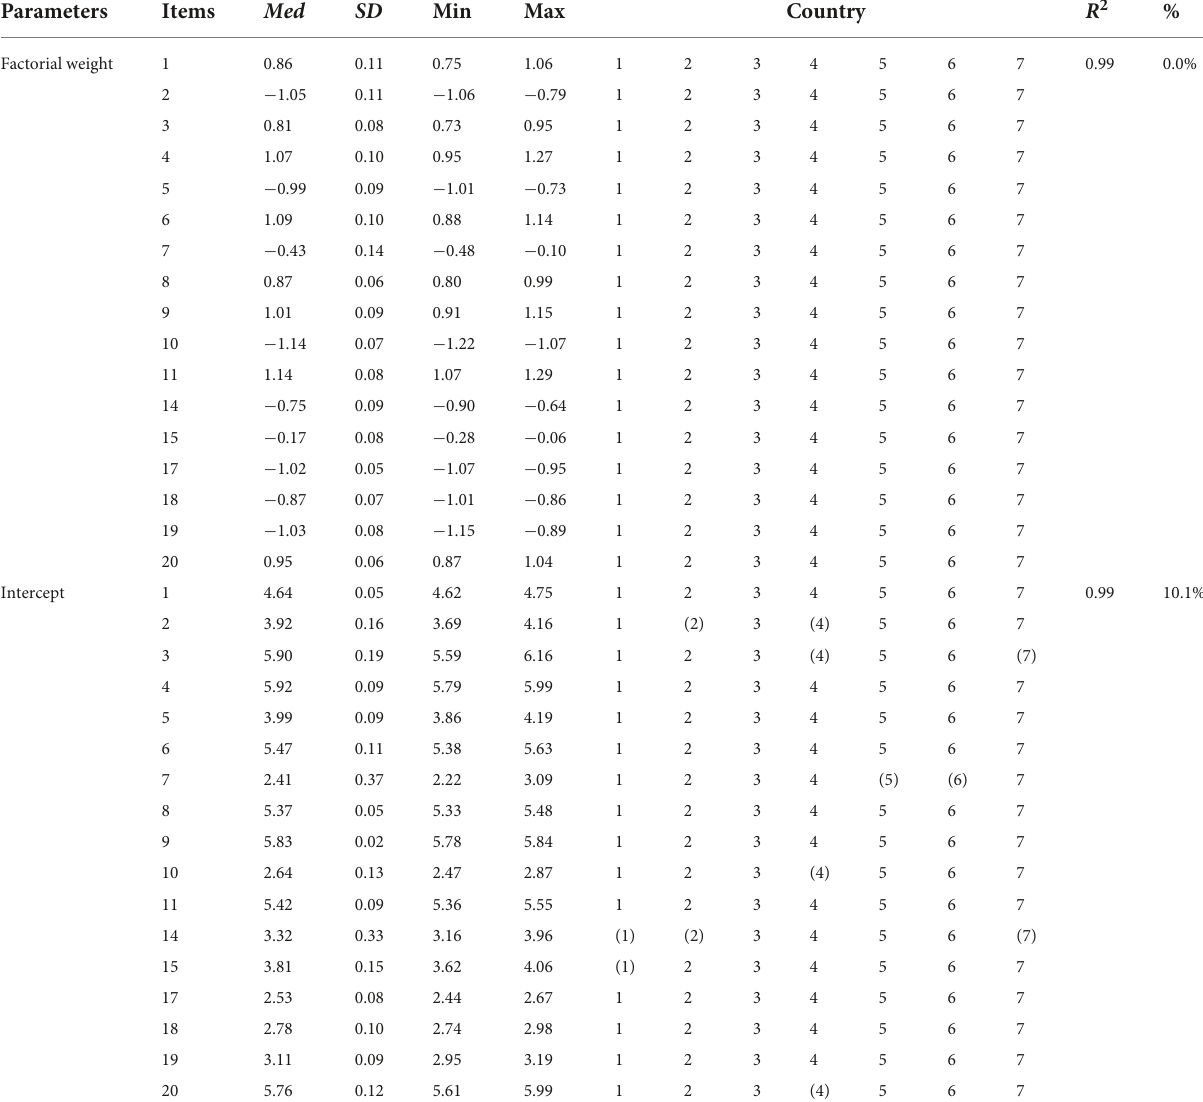
TABLE 5 ML invariance alignment (IA) in all seven countries.